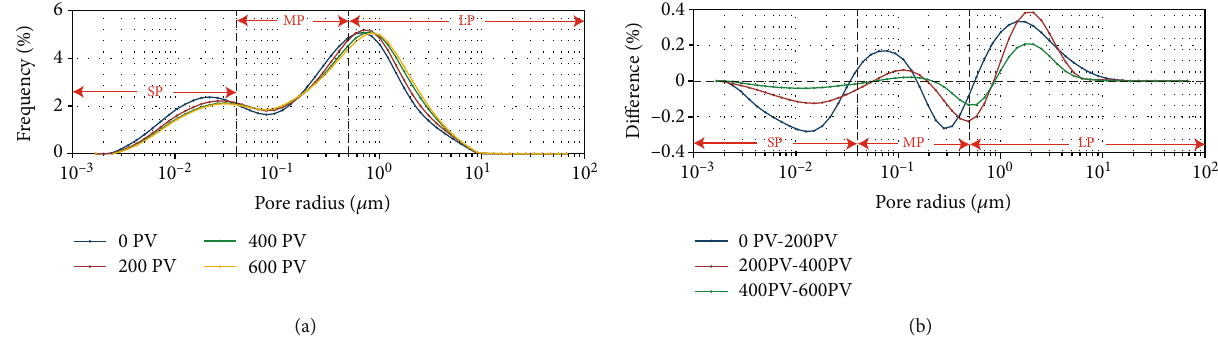
Figure 6: (a) Curves of pore-size distribution of C11-2 at four LTWF stages and (b) di ff erences between adjacent distribution